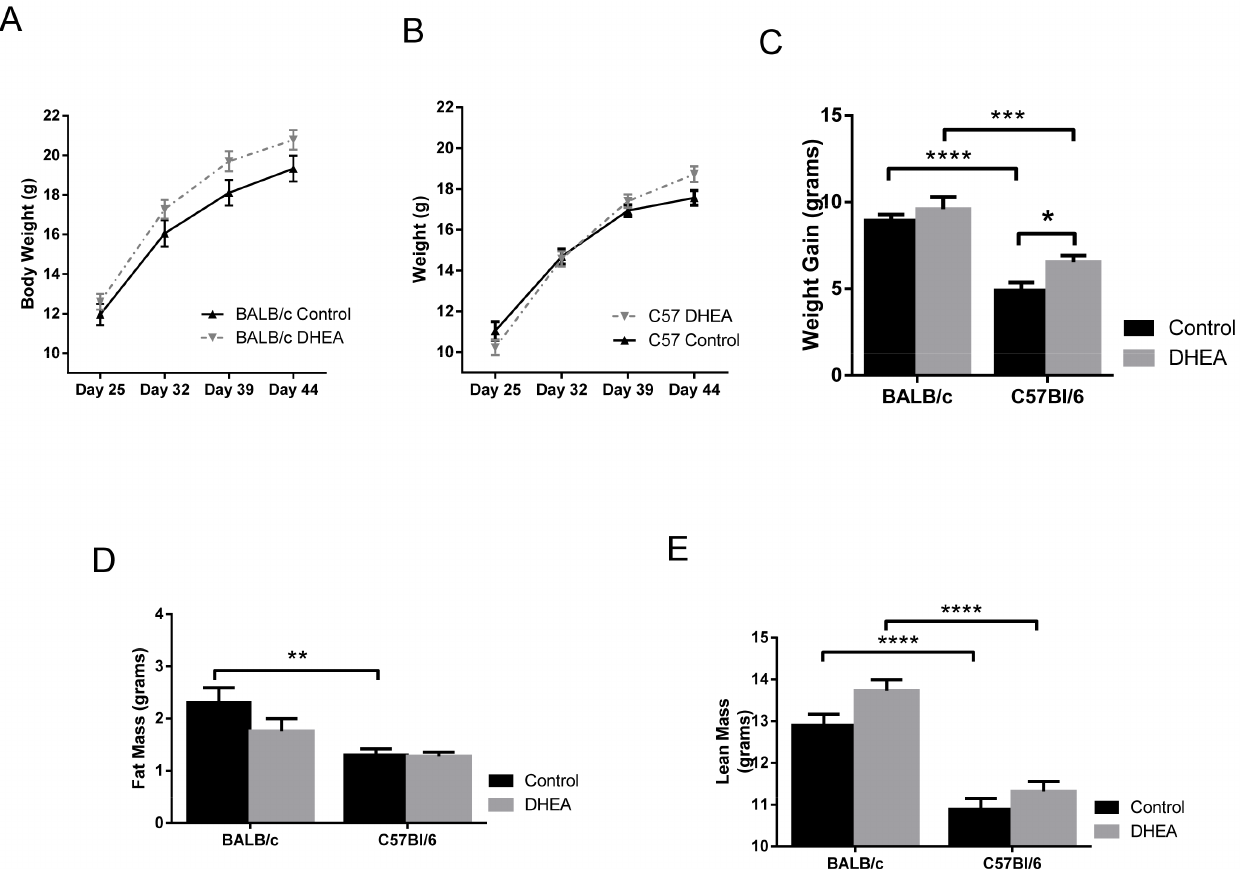
Figure 2. Body Composition of BALB/c and C57Bl6 strains following DHEA treatment. A. BALB/c and B. C57Bl/6 body weights over the course of treatment. C. Weight gain during study. D. Grams of fat mass by NMR (nuclear magnetic resonance). E. Grams of lean mass by NMR. N=6– 10 for all measurements.